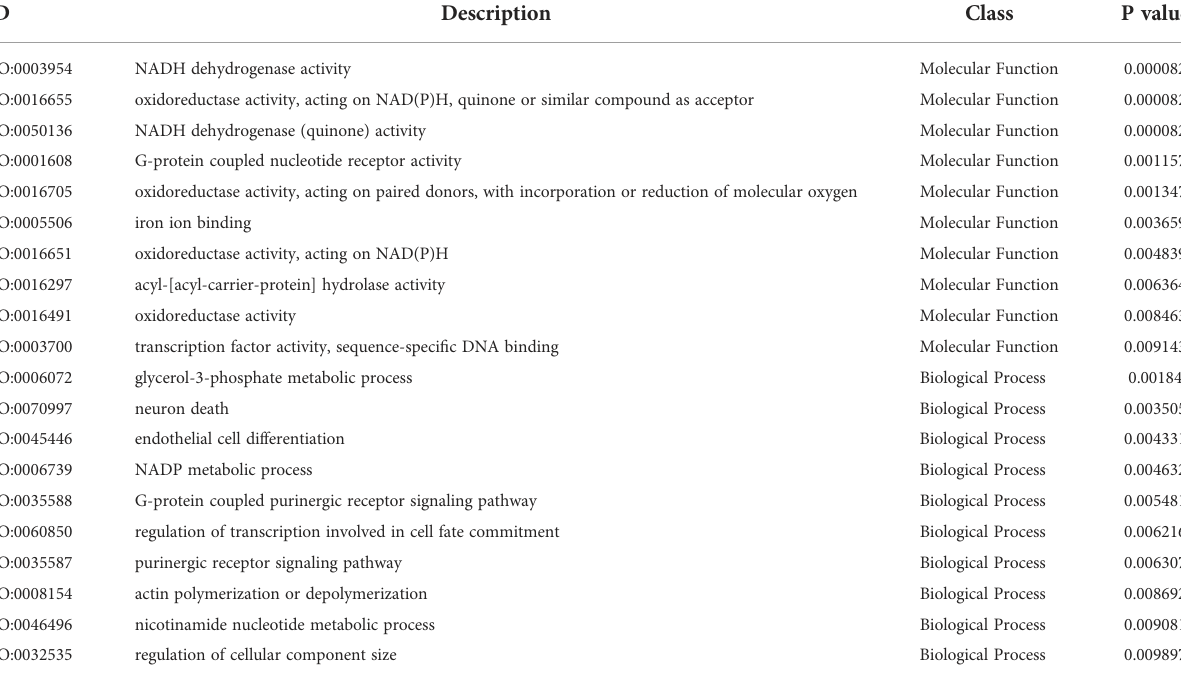
TABLE 8 ID, description, class and speci fi c P-value of Top 20 GO terms at 7 th post challenge day.